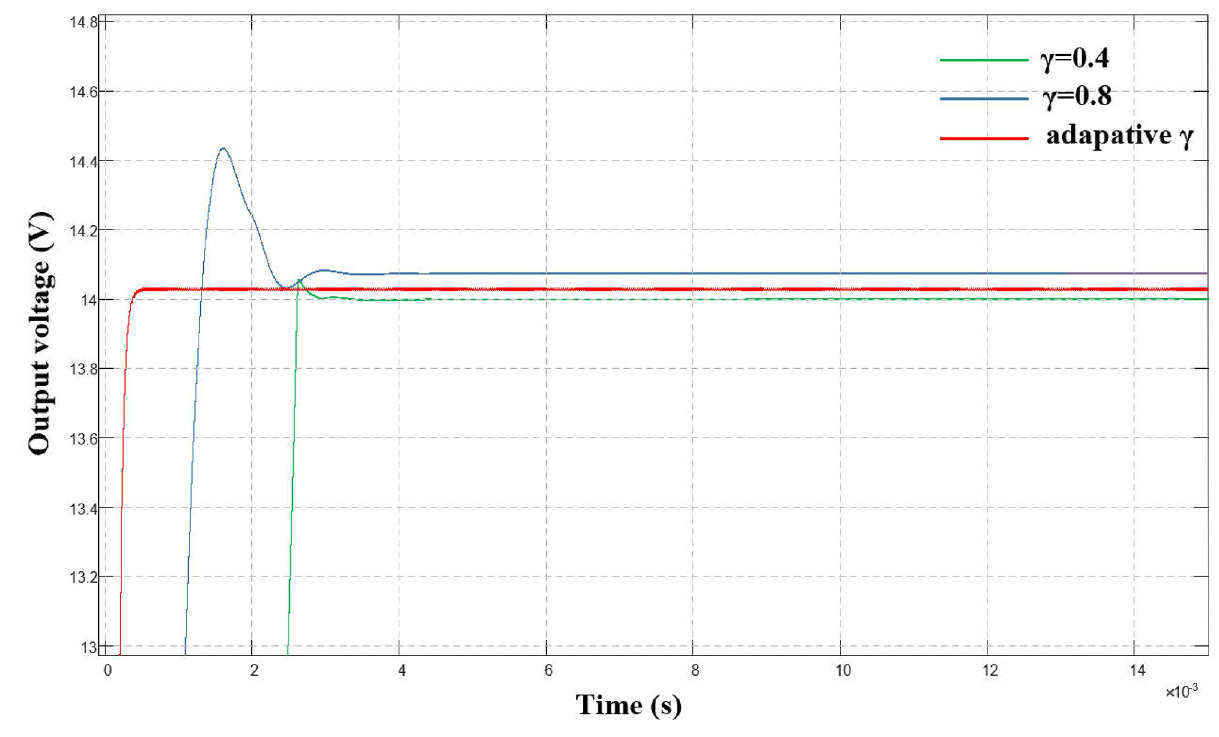
Fig 11. Comparison of output voltage waveforms at system startup.